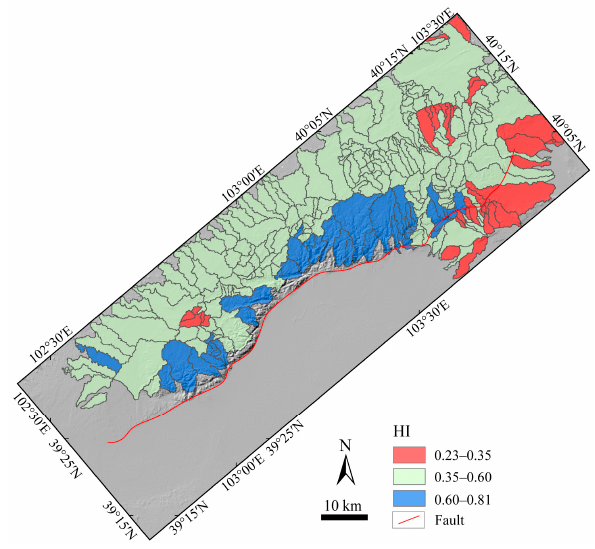
Figure 7. The HI values of the Yabrai Shan basins based on digital elevation model data.